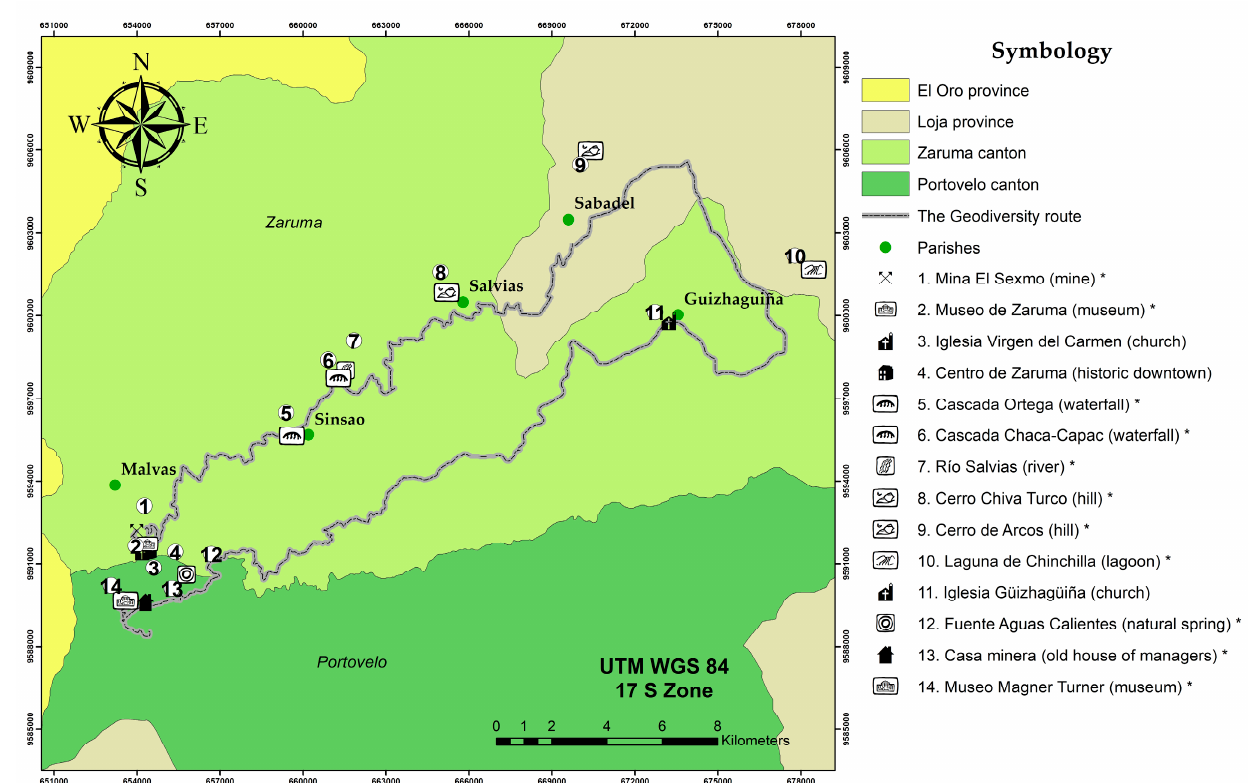
Figure 11. Map of the route “The Geodiversity” proposed by authors. * Geosites/mining